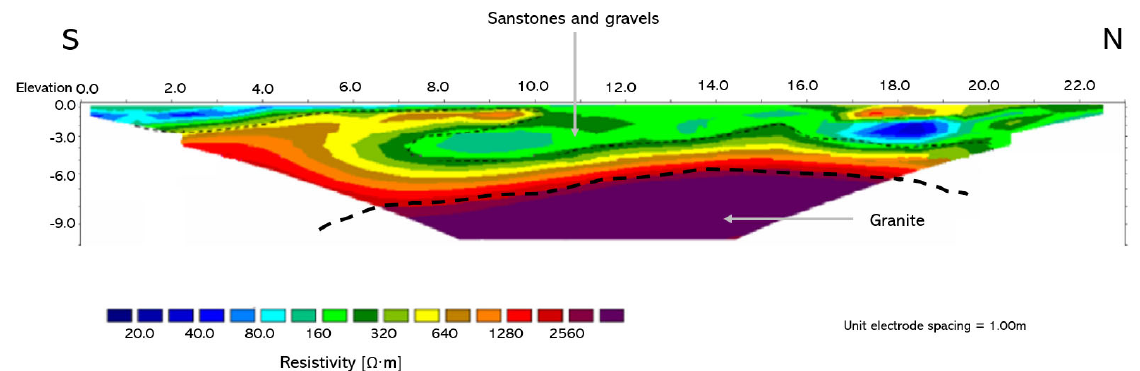
Figure 5. 2D electrical tomography profile for study case 1, Ávila.